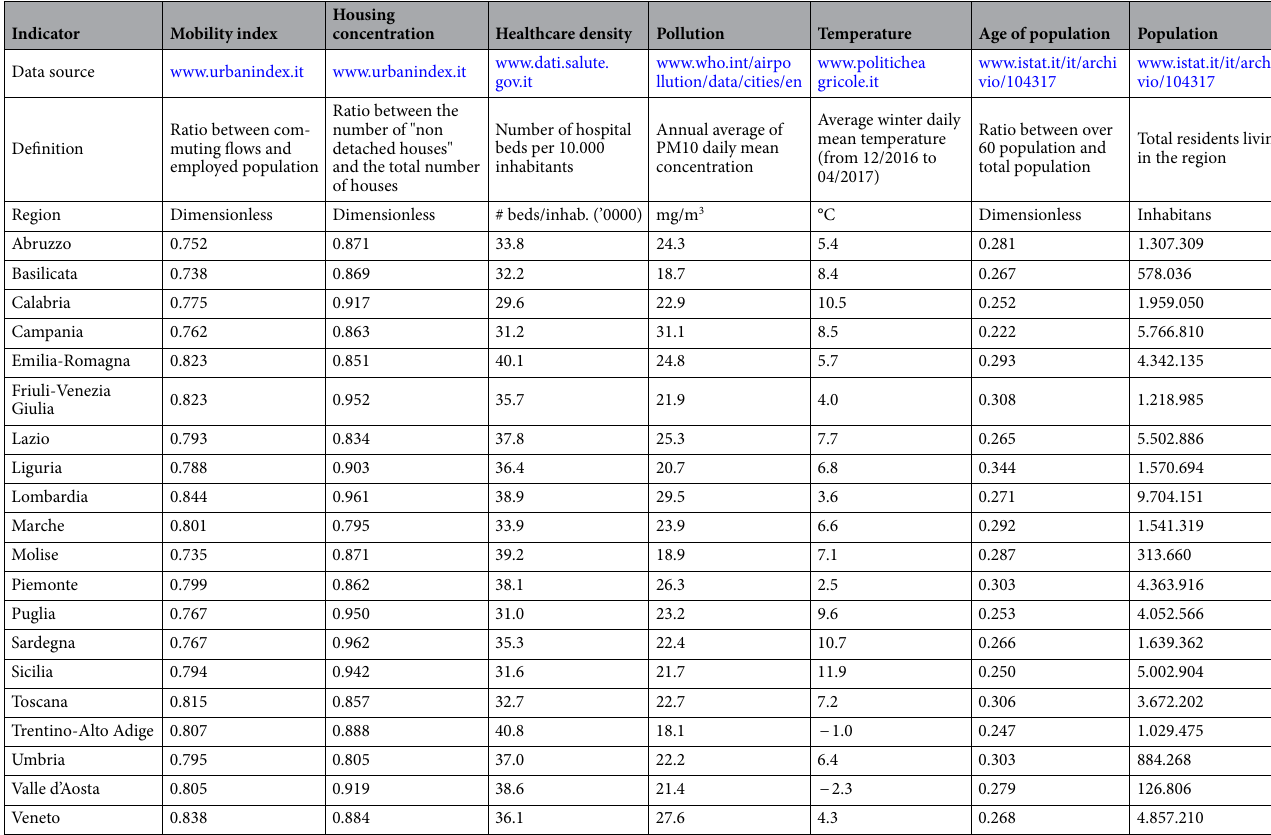
Table 1. The risk indicators original data are reported for each Italian region, together with their